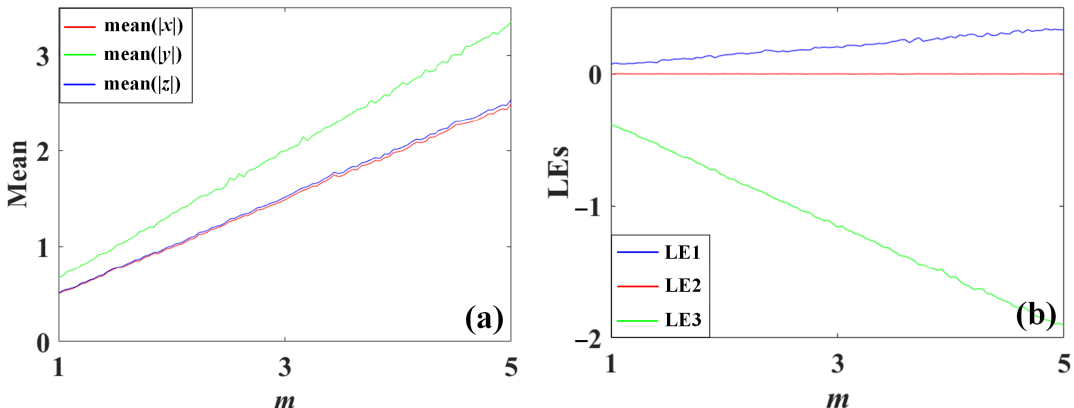
Figure 7. Amplitude evolution of the system (5) with a = 0.5, b = 0.6, c = 1.2 under initial condition (0, 1.3, 1) when m varies in [1,4]: ( a ) average values, ( b ) Lyapunov exponents.